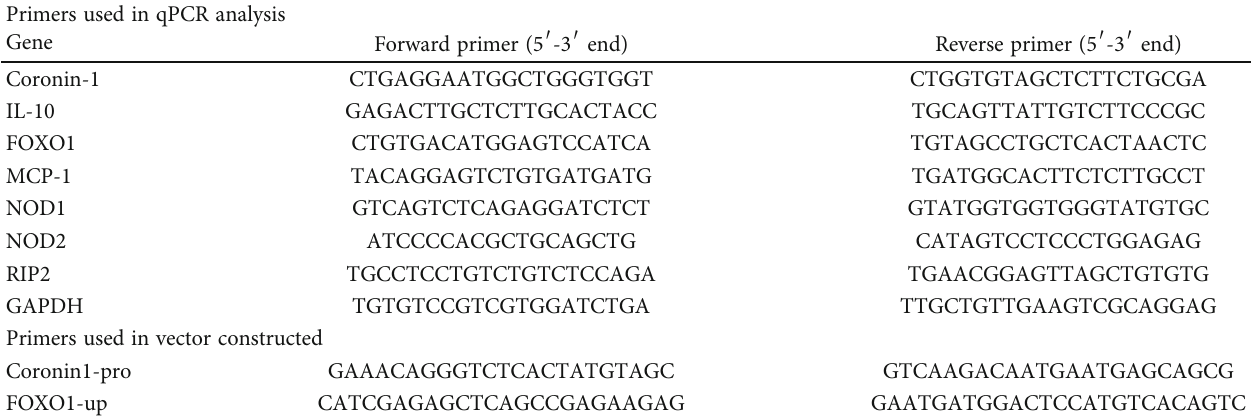
Table 1: Primers used in this